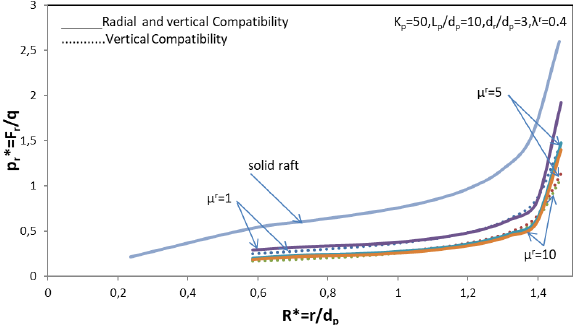
* =F /q) with normalized r r –effect of comparative p /d , on r p